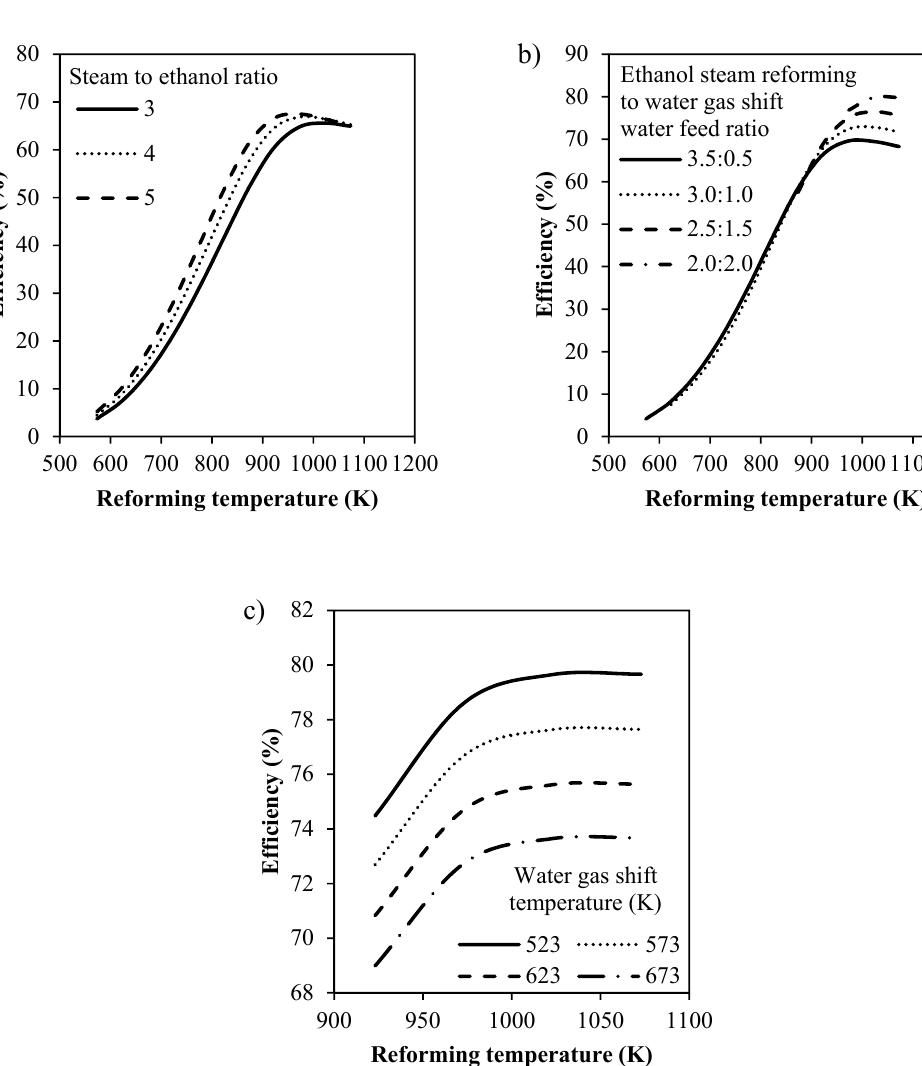
Figure 6. Process e ffi ciency in percent of ( a ) the SRSR operated at various steam to ethanol ratios and reforming temperatures under a pressure of 1 atm, ( b ) SRSR-WS operated at various reforming temperatures and spiting ratios of stream under a pressure of 1 atm and a steam to ethanol ratio of 4, and ( c ) CHIRS operated at various reforming and water gas shift temperatures under a pressure of 1 atm and a steam to ethanol ratio of 4.